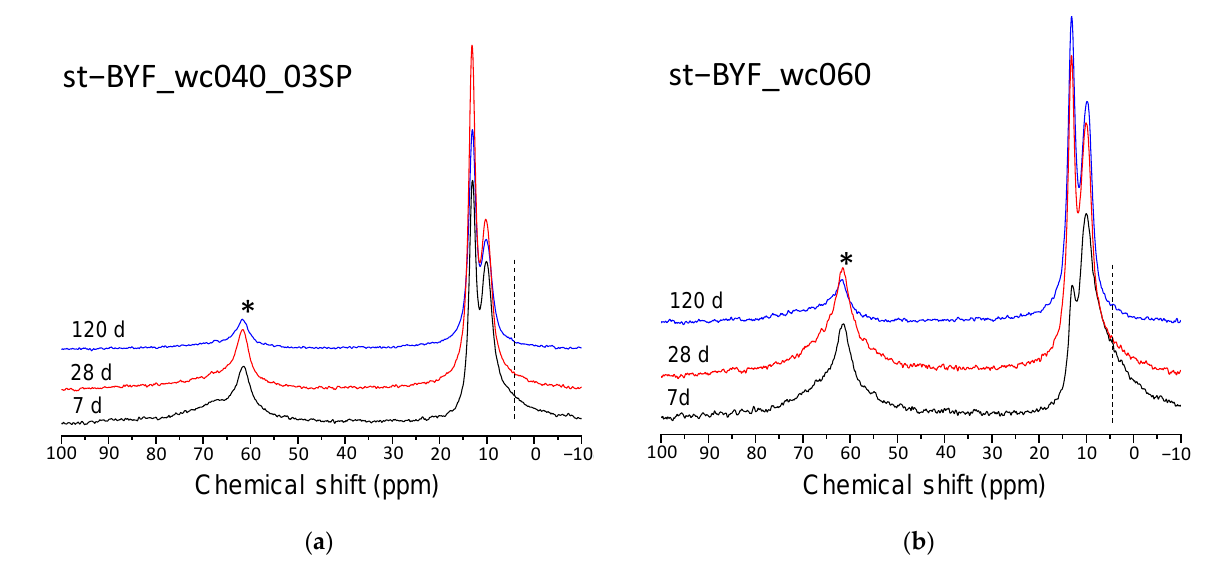
Figure 5. 27 Al MAS-NMR spectra for ( a ) st-BYF_wc040_03SP and ( b ) st-BYF_wc060 as a function of time. Asterisk indicates the interlayer IV Al resonance due to stratlingite. Vertical dashed lines mark the resonance due to VI Al in AH 3 -gel.